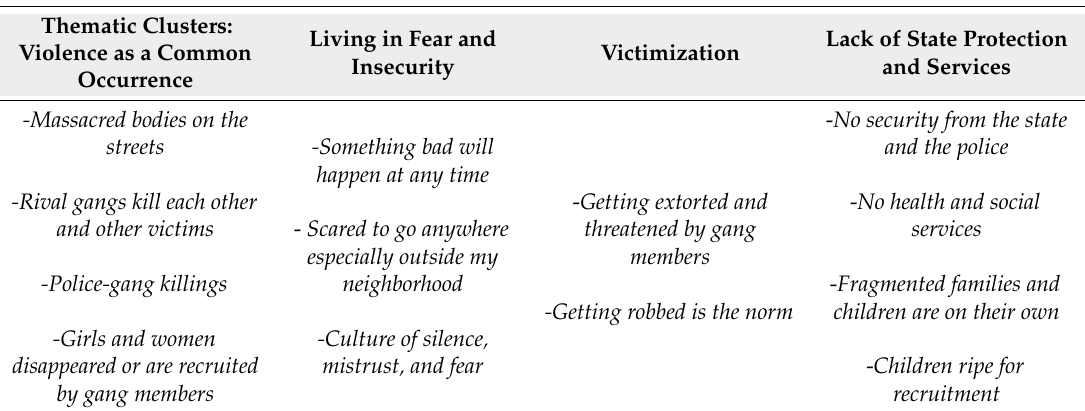
Table 1. An overview of descriptive subthemes (first-level thematic analysis), thematic clusters (second-level thematic analysis) and first meta-theme (third-level thematic analysis).